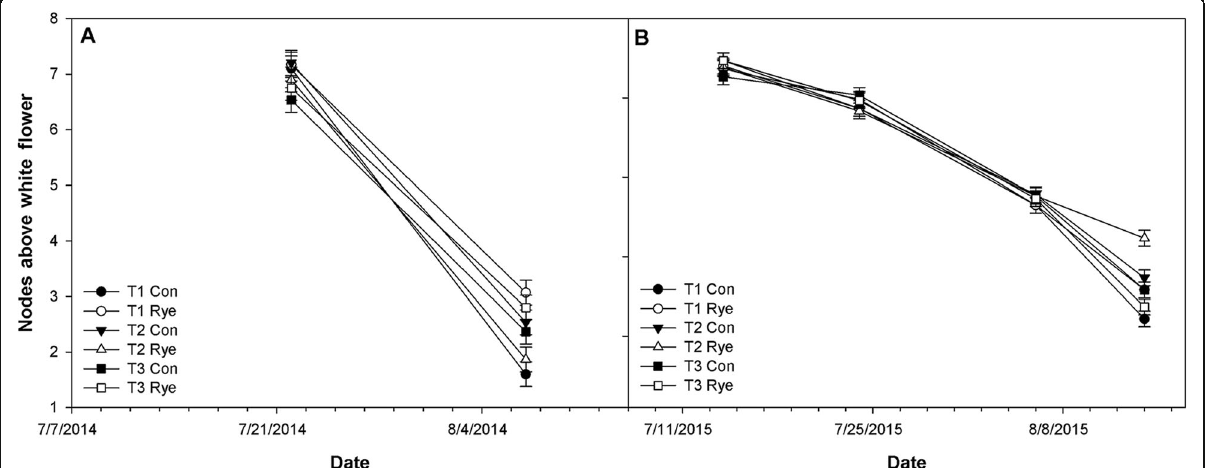
Fig. 4 Mainstem nodes above the first position white flower for cotton grown under irrigation regimes T1-T3 and planted into either conventionally tilled beds (Con) or a heavy rye cover crop residue (Rye) during the 2014 ( a ) and 2015 ( b ) growing seasons at a field site near Tifton, GA. Values are means ± standard error ( n = 6)